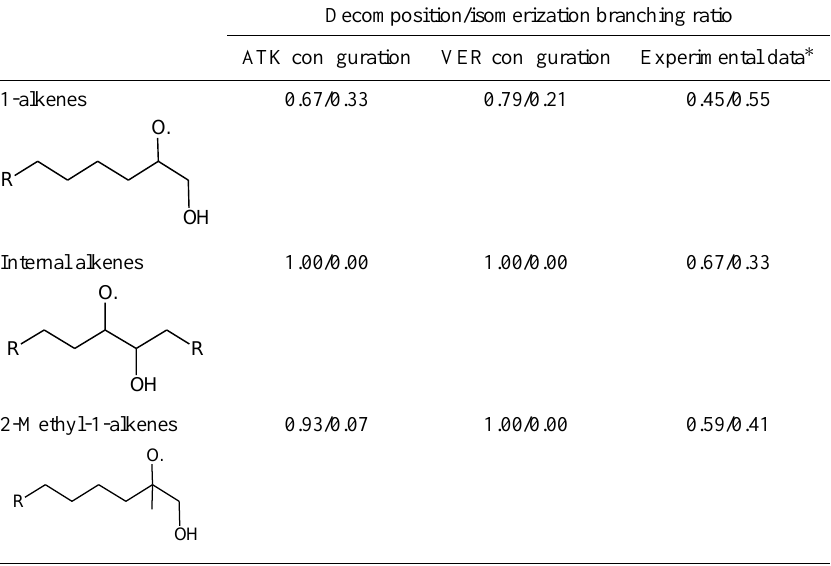
Matsunaga et al. (2009), Aschmann et al. (2010) and Ziemann (2011).